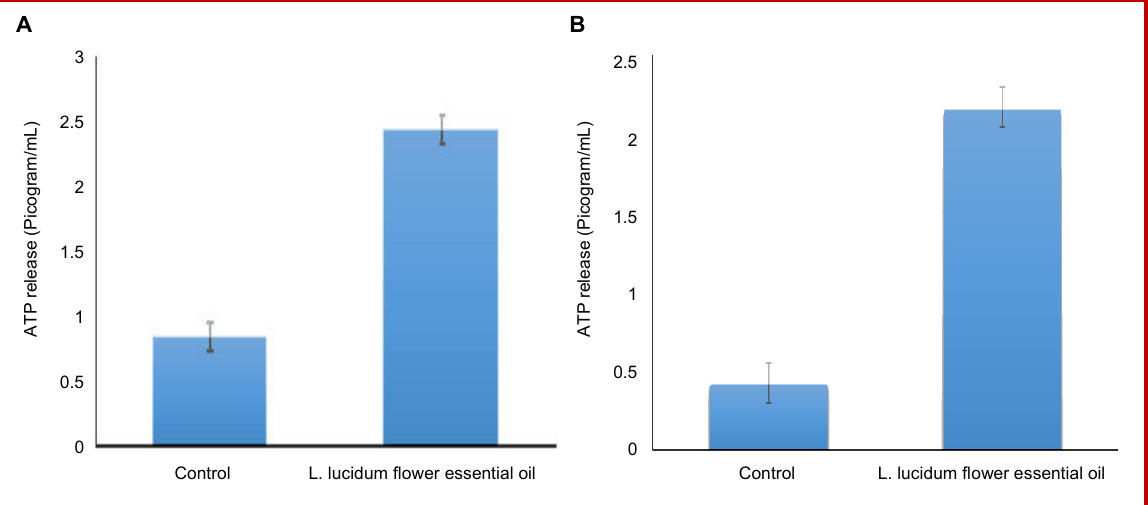
Figure 2: Effect of flower essential oil of Ligustrum lucidum on extracellular ATP concentration of S. aureus KCTC-1621 (A) and S. enterica ATCC-4731 (B). Data are expressed as mean ± SD (n =